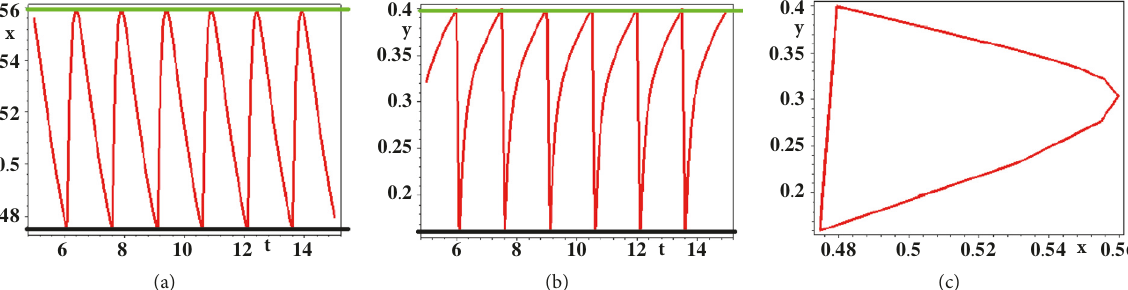
Figure 5: Time series and phase portrait of the order-1 periodic solution of system (6) with the parameters 𝐴 = 12,𝑞 = 0.4, 𝐵 = 3.5 , 𝐻 = 0.3748366014 , 𝐸 = 0.01, 𝐸 = 1 2